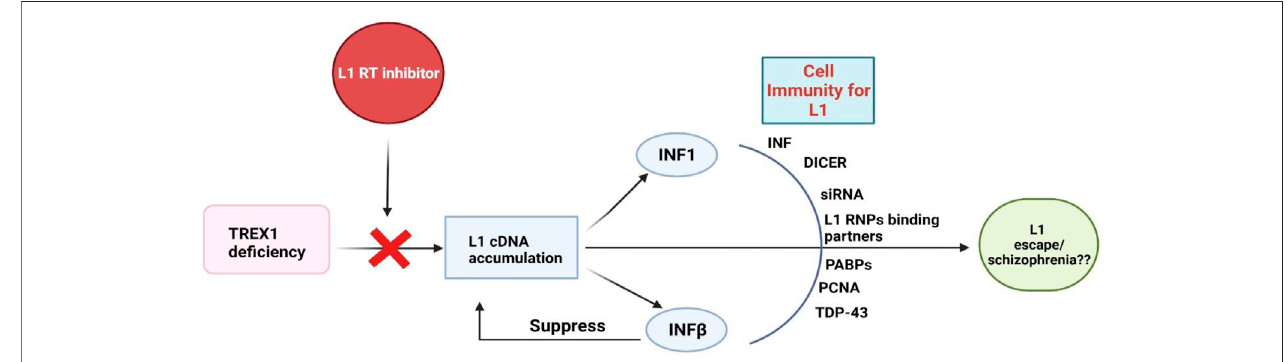
FIGURE 1 | Cellular immune responses to L1s. TREX1: Three Prime Repair Exonuclease 1, INFs : Interferons, PABPs: poly-A binding proteins, PCNA: Proliferating cell nuclear antigen, TDP-43: TAR DNA binding